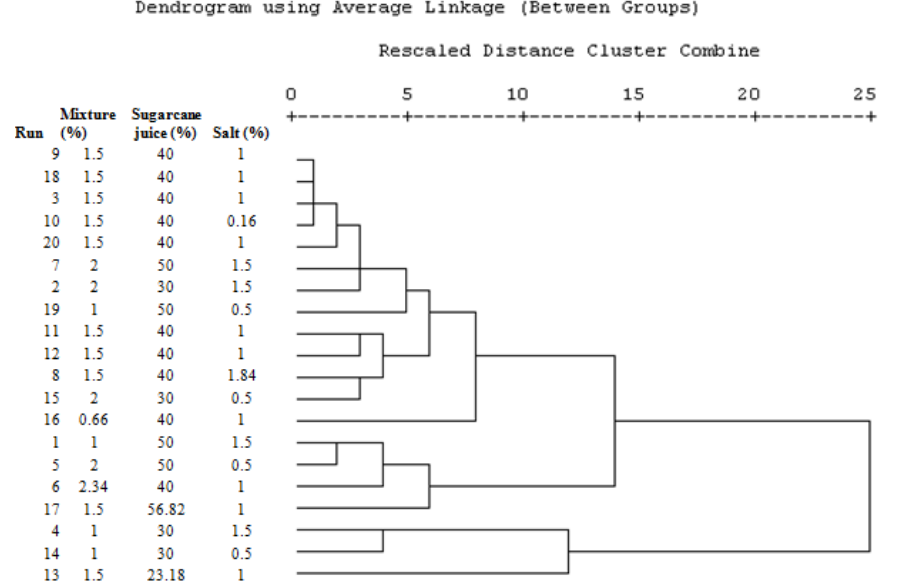
Table 3. Software generated optimum conditions for preparation of blended cucumber juice along with its predicted and experimental values for the best blend and phytochemicals